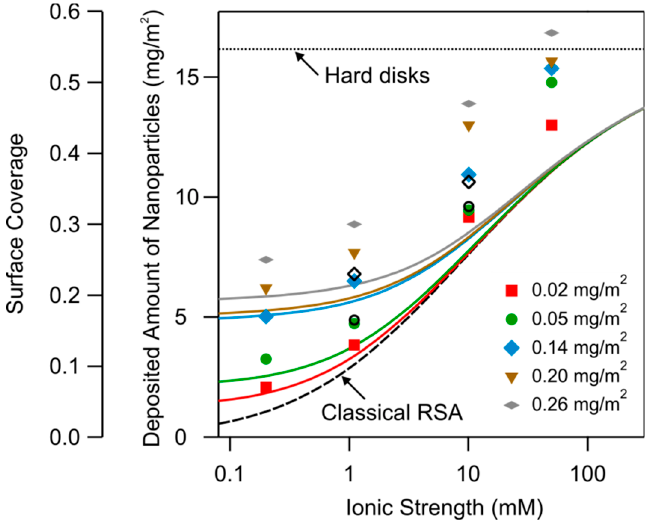
Figure 12. Maximum deposited number of nanoparticles on the PDADMAC-functionalized silica surface at pH 4.0 versus the ionic strength for different adsorbed amounts of PDADMAC. The solid lines represent calculations with the three-body RSA model. The dashed line indicates the result of the classical RSA model, while the dotted line indicates the jamming coverage for hard disks. The surface coverage is also indicated as the leftmost axis. Full and open symbols refer to in situ and ex situ functionalized substrates, respectively.